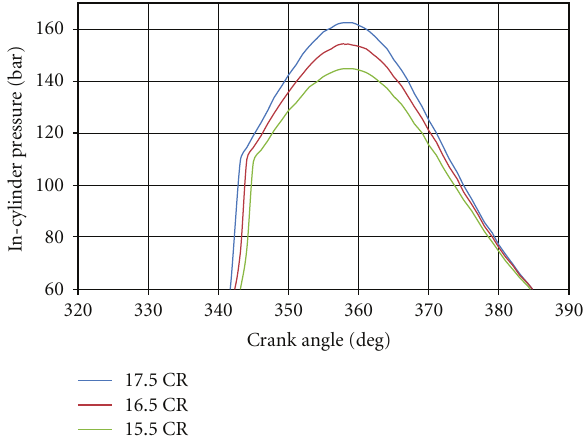
Figure 20: E ff ect of compression ratio on in-cylinder pressure (1400rpm; 50% load; 0%